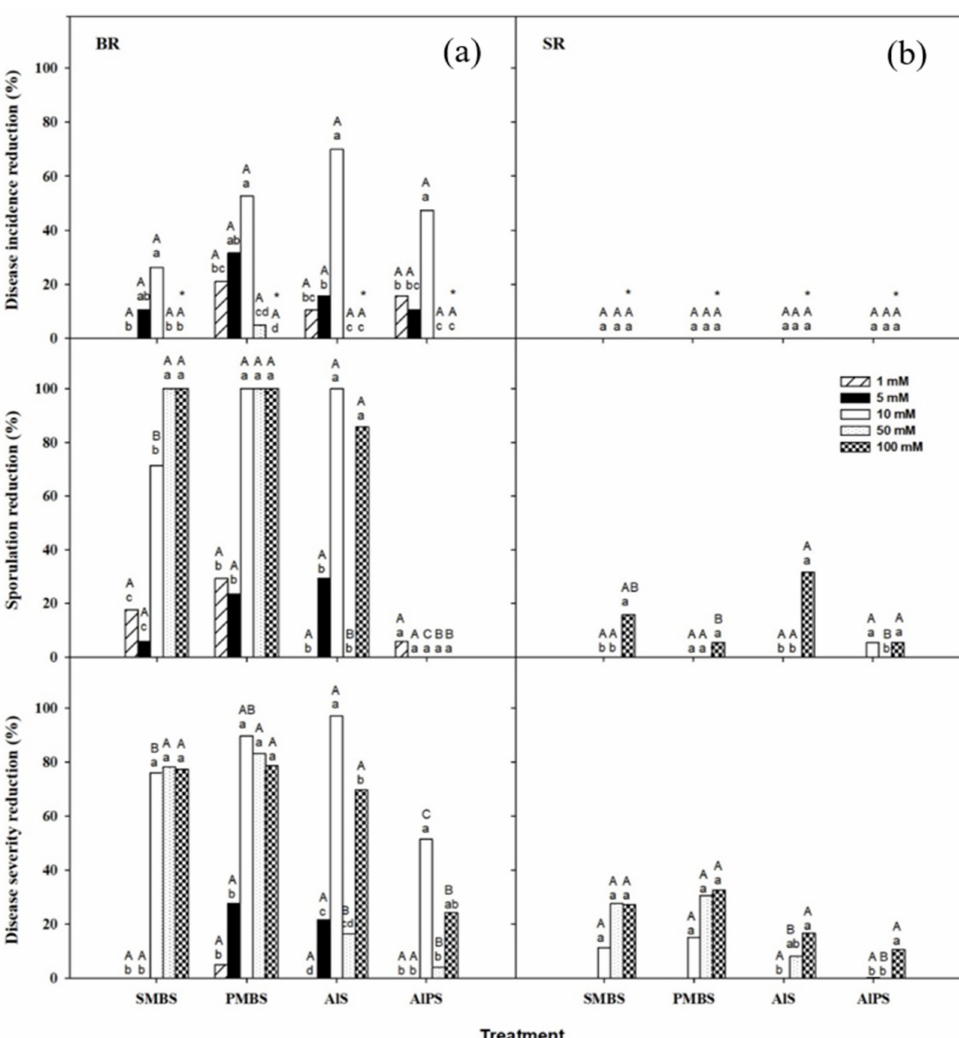
Figure 1. Curative activity of sodium metabisulfite (SMBS), potassium metabisulfite (PMBS), alu- minum sulfate (AlS), and aluminum potassium sulfate (AlPS) at different concentrations against ( a ) brown rot (BR) and ( b ) sour rot (SR) in in vivo primary screenings with ‘Luciflora’ nectarines artificially inoculated with Monilinia fructicola and Geotrichum candidum , respectively, treated 24 h later, and incubated for 8 days at 20 ◦ C. Five salt concentrations (1, 5, 10, 50, and 100 mM) were evaluated against BR, while three (10, 50, and 100 mM) were evaluated against SR. Disease reductions were determined with respect to control fruit treated with water, in which incidence, sporulation, and severity were respectively 95%, 85%, and 63.6 mm for BR and 100%, 95%, and 40.5 mm for SR. For each disease and dependent variable, columns with different capital letters indicate significant differences among salts for each concentration, and columns with different lowercase letters indicate significant differences among concentrations for each salt, according to Fisher’s protected LSD test ( p < 0.05) applied after an ANOVA. Incidence and sporulation values were arcsine-transformed. Non-transformed means are shown. * indicates treatments that caused visible peel